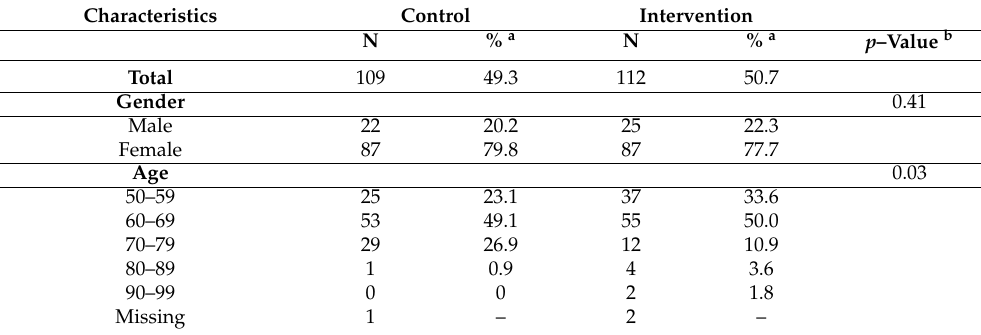
Table 2. Participant characteristics by assigned